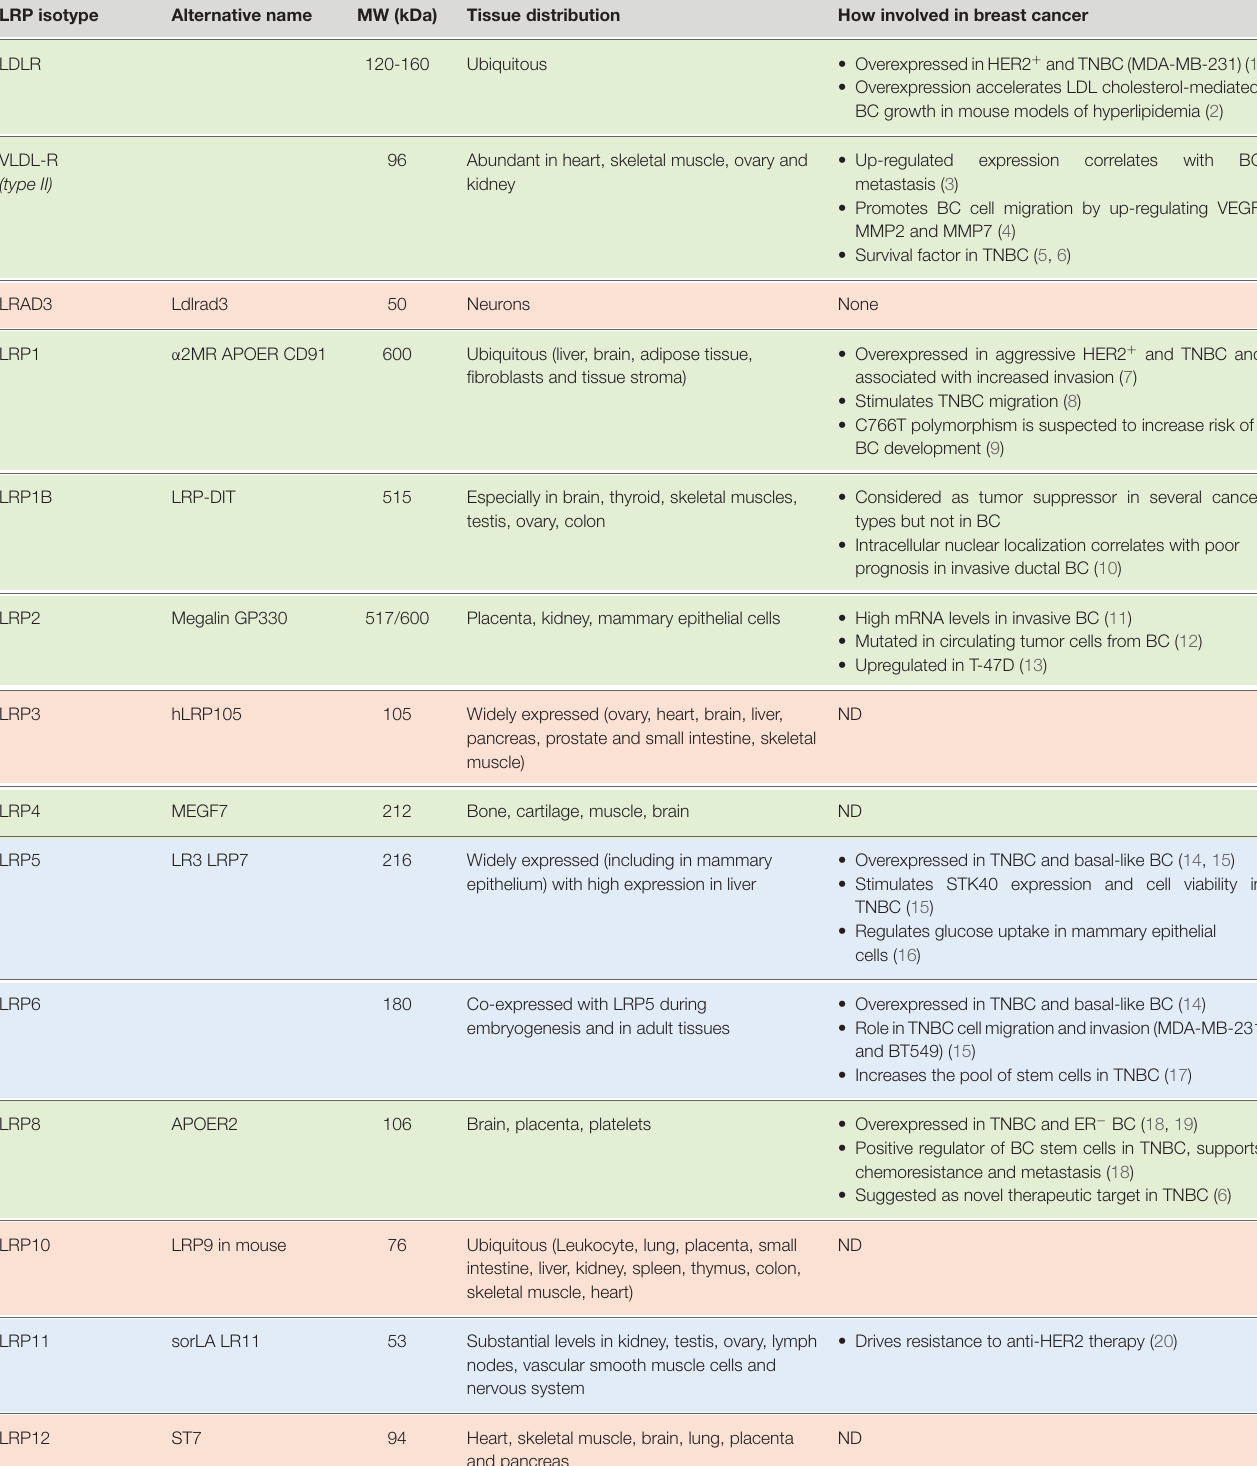
TABLE 1 | The 14 members of the low-density lipoprotein receptor family and their involvement in breast cancer. LRP